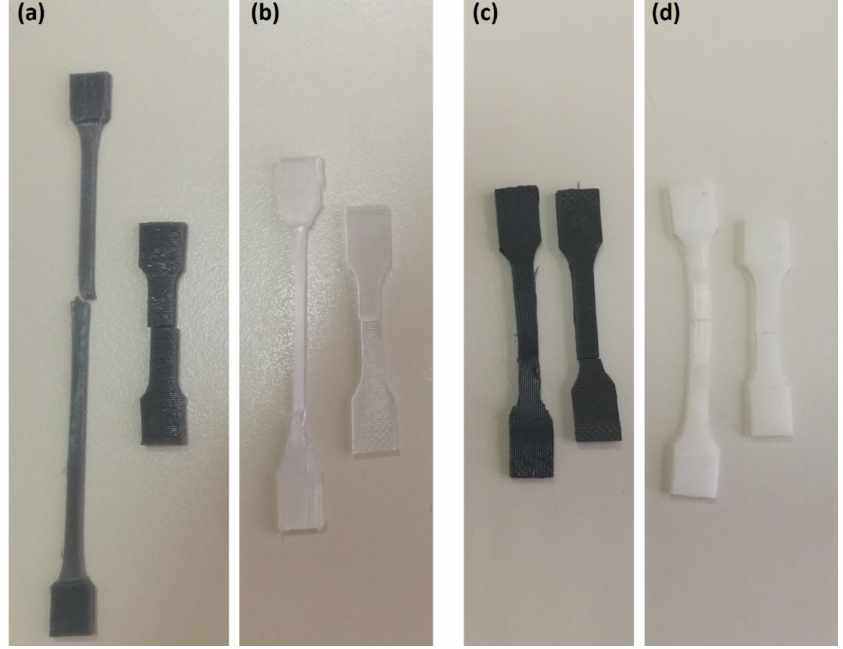
Figure 8. Failure mode for the tested 3D samples: ( a ) PETG-S, ( b ) PETG-F ( c ) PLA-T and ( d )